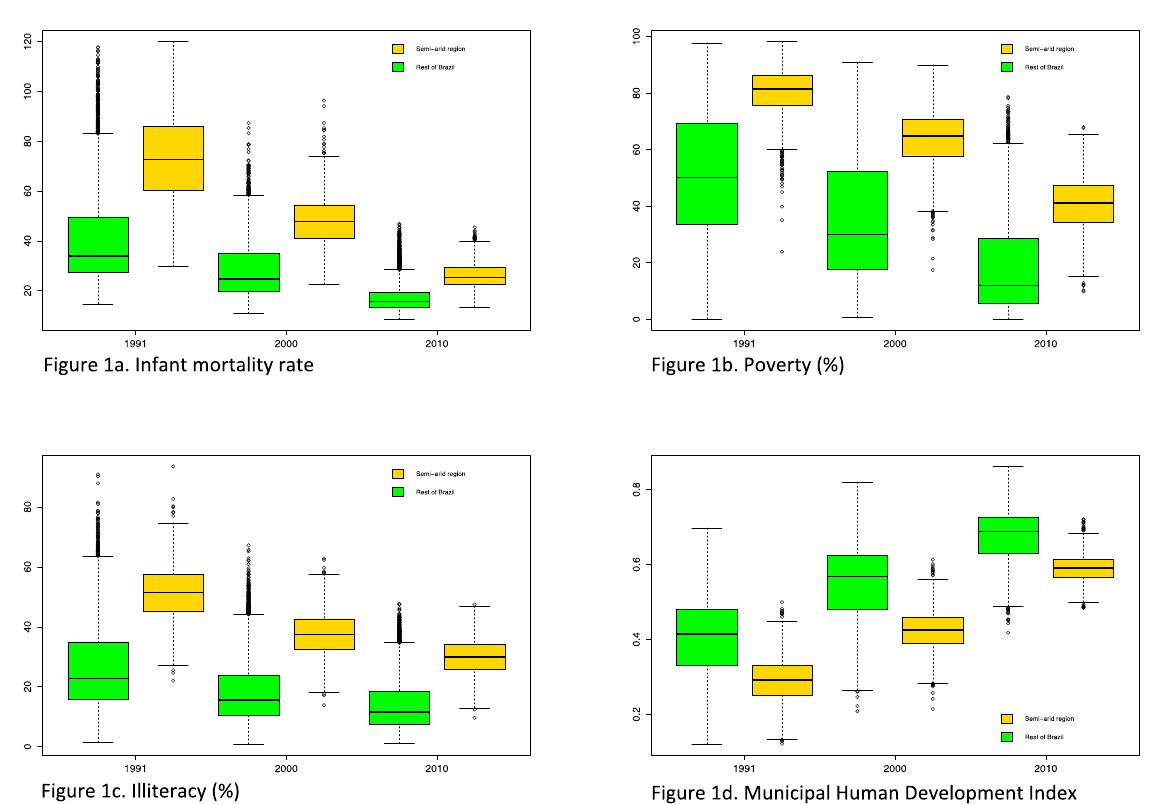
Figure 1. Trends in selected indicators for 5565 municipalities—in the semiarid region (1133) and the rest of Brazil (4432)—for 1991, 2000 and 2010: ( a ) infant mortality rate, ( b ) poverty rate, ( c ) illiteracy rate, and ( d ) Municipal Human Development